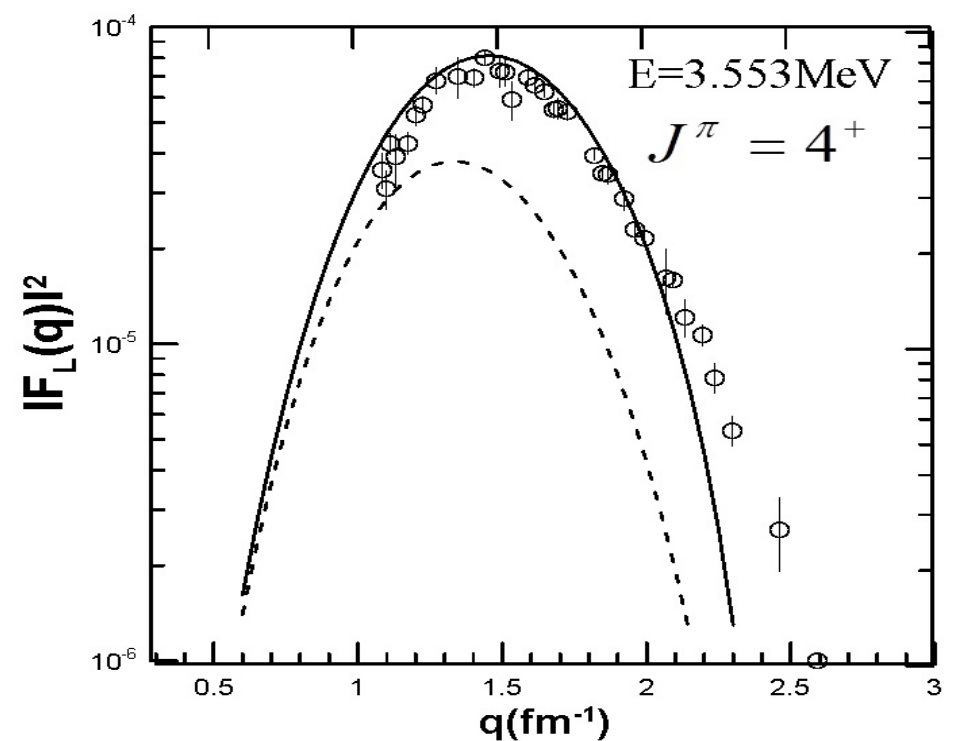
Fig. 1: Inelastic Coulomb 4 C form factors for the transition to the 14  (3.553 MeV) state. The long-dashed and solid curves are the calculated 4 C form factors without and with the inclusion of the effect of the SRC, respectively. The open circle symbols are those of the experimental data taken from ref.